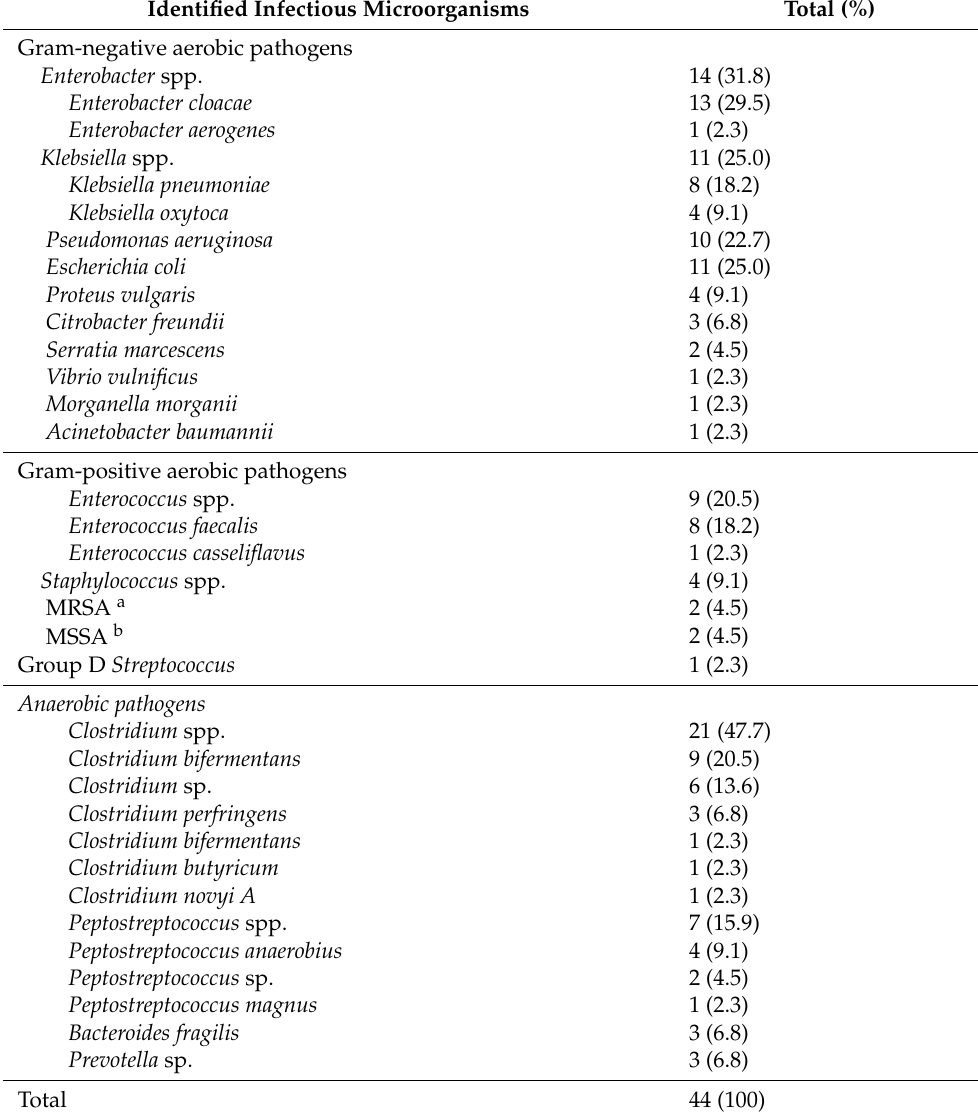
Table 4. Summary of identified infectious microorganisms in 44 patients of Aeromonas polymicrobial NF of the